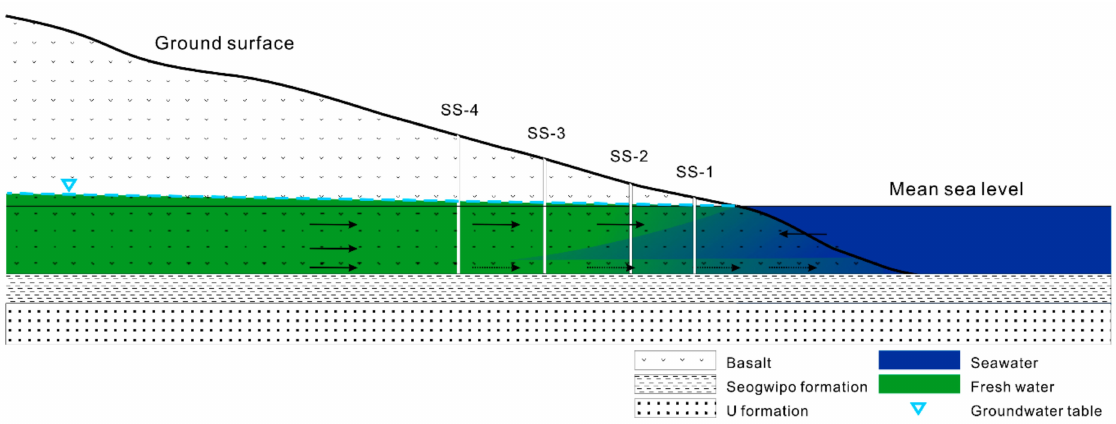
Figure 10. Conceptual model of seawater intrusion on the eastern coast of Jeju